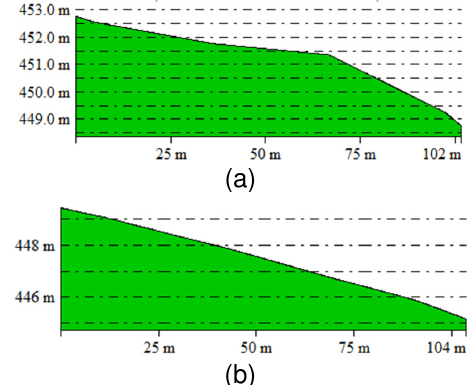
Fig 4. Topographic profil on data (a) SRTM30, (b) DTM ASTER GDEM and SRTM30 which has the same spatial resolution and the error rate is almost the same at that point has a height range which does not differ with TerraSAR-X. The maximum height of the ASTER GDEM is + 452 m, while SRTM30 is + 453 m. DTM from TerraSAR-X has a resolution of 10m, and a maximum height of the DTM is + 449 m. Those values are still relevant with regard to the resolution of the DEM used, with reference to the sample points that have relatively low accuracy and the topography is relatively